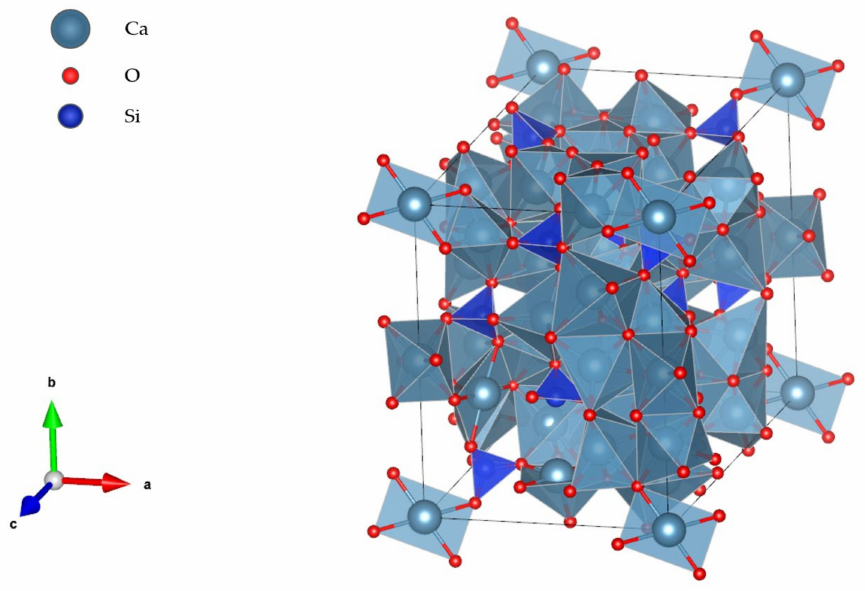
Figure 1. The lattice structure of tricalcium silicate (modified from [46]). Considering the thermodynamics of the reaction between alite and water, a high heat of hydration is observed within the first few seconds. The reaction would then reduce during about 30 min and remain at a constant low rate of less than 1 mW/g. This steady state would last for about 1–2 h and would be consequently led to slow expansion. By the end of this period, the rate of hydrolysis would again increase at about 2 h into the hydration, reaching a secondary maximum at around 9 h, before gradually decreasing again [47]. Thus, five distinct stages can be seen in the hydration of alite, as shown in Figure 2.